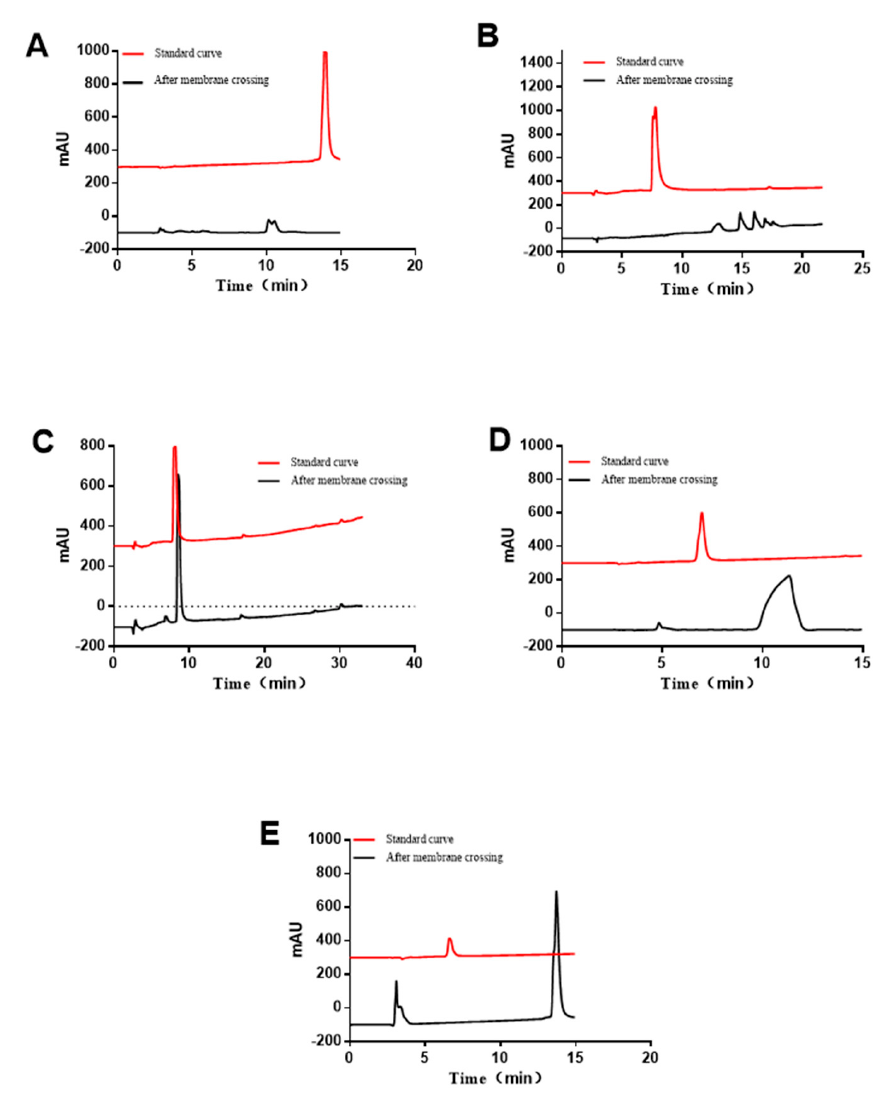
Figure 5. The composition of the five peptides analyzed by RP − HPLC after passing through the Caco − 2 cell monolayer. ( A ) RYPLGYL ( B ) KHPIKH ( C ) KHPIK ( D ) FFSDK ( E )YGG.